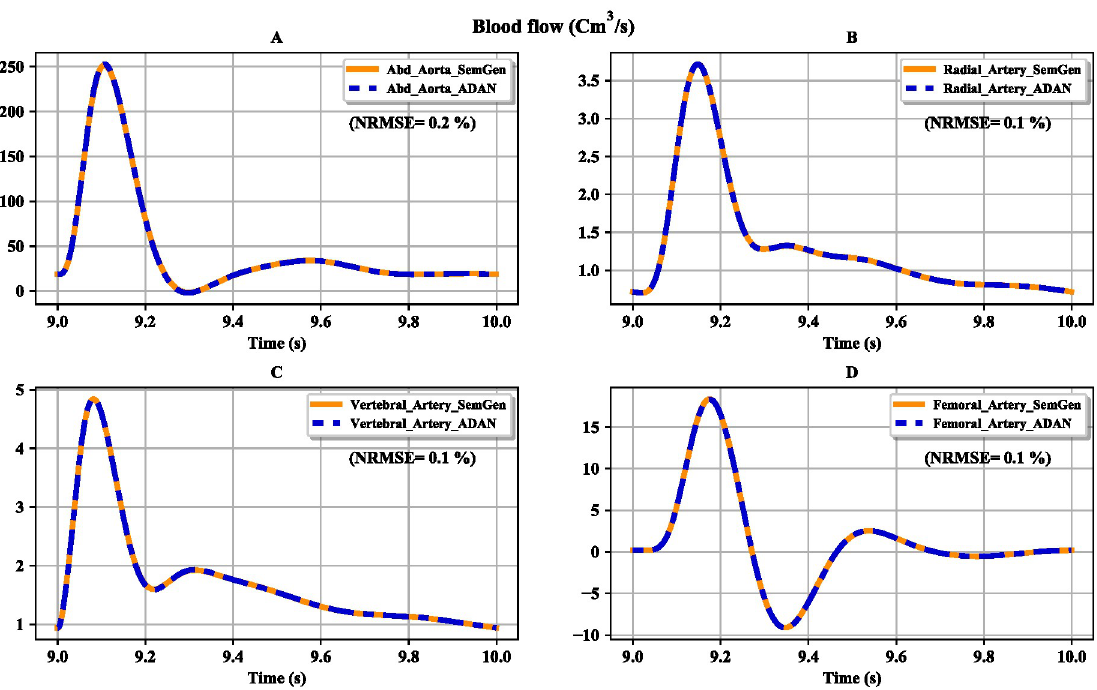
Fig 11. Comparison between the flows obtained from the ADAN open-loop model and our version of the model. (A) Flow in the abdominal aorta; (B) flow in the radial artery; (C) flow in the vertebral artery; (D) flow in the femoral artery. The normalised root mean square errors (NRMSE) are represented as